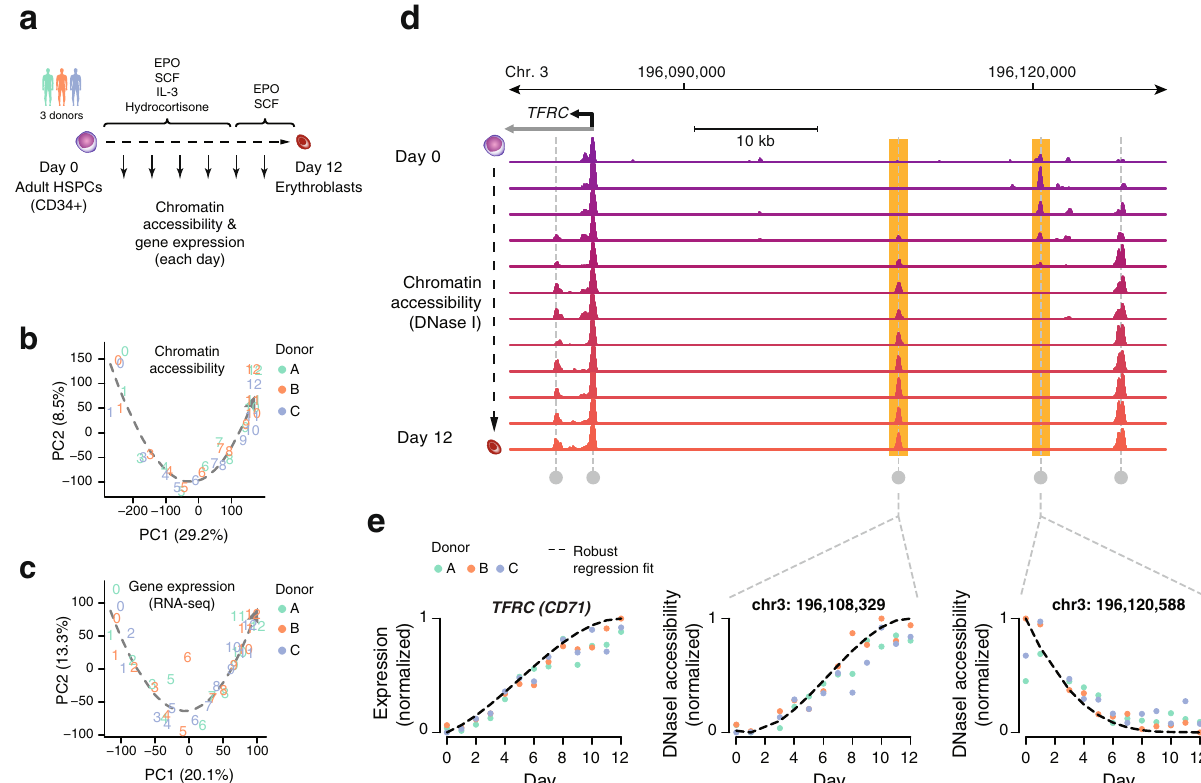
Fig. 1 Comprehensive identi fi cation of regulatory landscape developmental dynamics. a Dense DNase I-seq and RNA-seq time course with daily sampling during the 12-day ex vivo erythroid differentiation induced from CD34 + HSPCs. b PCA analysis using all detected DHSs (79,085 Hotspots 5% FDR) across all samples (12 time points, 3 donors). The arrow denotes the differentiation trajectory from day 0 to day 12. c PCA analysis using all 24,849 detected genes across all samples (13 time points, 3 donors). The arrow denotes the differentiation trajectory from day 0 to day 12. d Chromatin accessibility tracks for each day of differentiation with DNase Hypersensitive Sites (DHSs) harbored around the TFRC locus. e Identi fi cation of signi fi cantly changing DHS and genes with robust linear regression analysis. Scatterplots show TFRC expression and DNase I density for two upstream DHS. Dots represent normalized values for each of the 3 donors. Dashed line represents the fi tted regression